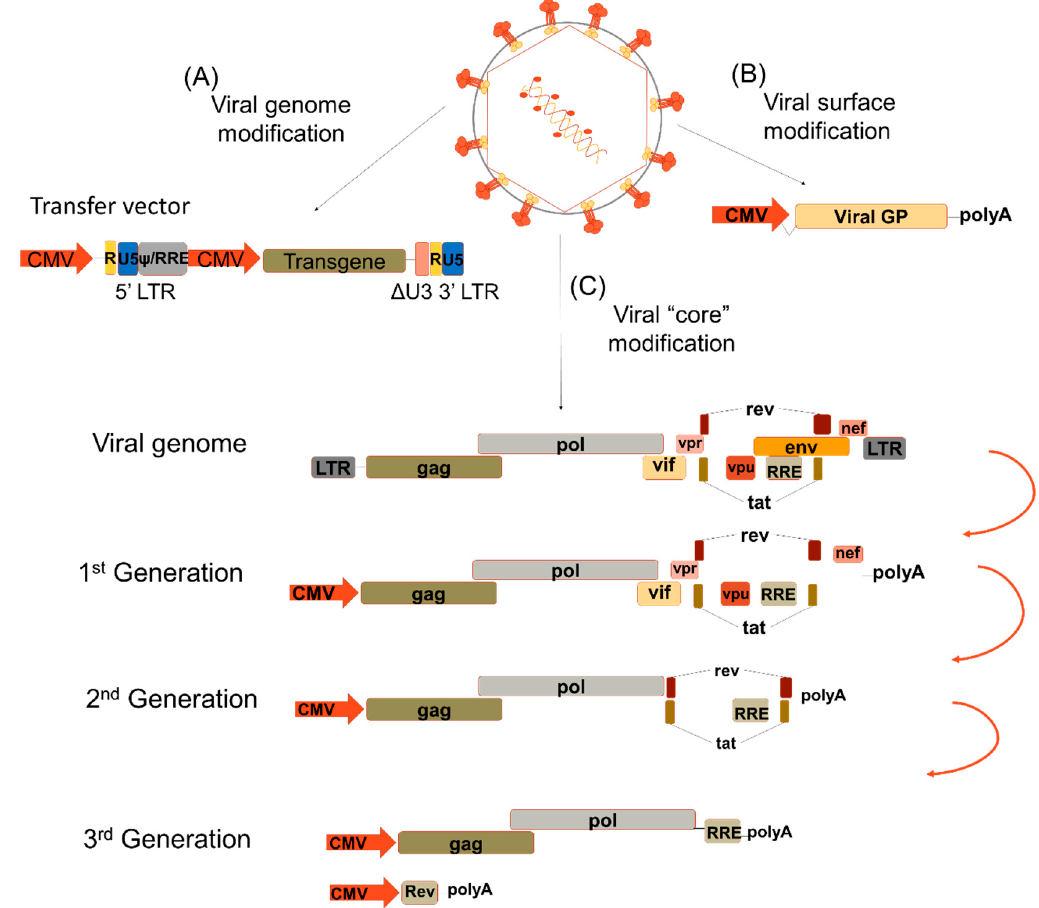
Figure 1. Lentiviral modifications. ( A ) The transfer vector contains the long terminal repeats (LTR) and the transgene is under a strong internal promoter, i.e., CMV. ( B ) The viral surface proteins are exchanged by different viral glycoproteins to confer them a different tropism according to the cell targeted for transduction. ( C ) The viral genome encodes three genes flanked by LTRs: structural (gag, pol and env), regulatory (rev and tat) and accessory (vif, vpr, vpu and nef). The 1st generation lentiviral vectors (LVs) contained all the viral proteins with the exception of the Env protein. The 2nd generation LV does not express any of the accessory proteins. The 3rd generation LV is divided in two; one expresses the structural proteins gag and pol while the other expresses the regulatory protein rev. LTR—long-terminal repeats; U5—5 ′ UTR; U3- 3 ′ UTR; ψ —Psi packaging element; RRE—Rev response element; CMV—cytomegalovirus; Viral GP—viral glycoprotein; gag—group-specific antigen; pol—DNA polymerase; env—viral envelope; rev- transactivating protein; tat—trans-activator of transcription; vif—viral infectivity factor, vpr—viral protein R; vpu—viral protein u; nef—negative regulatory factor.